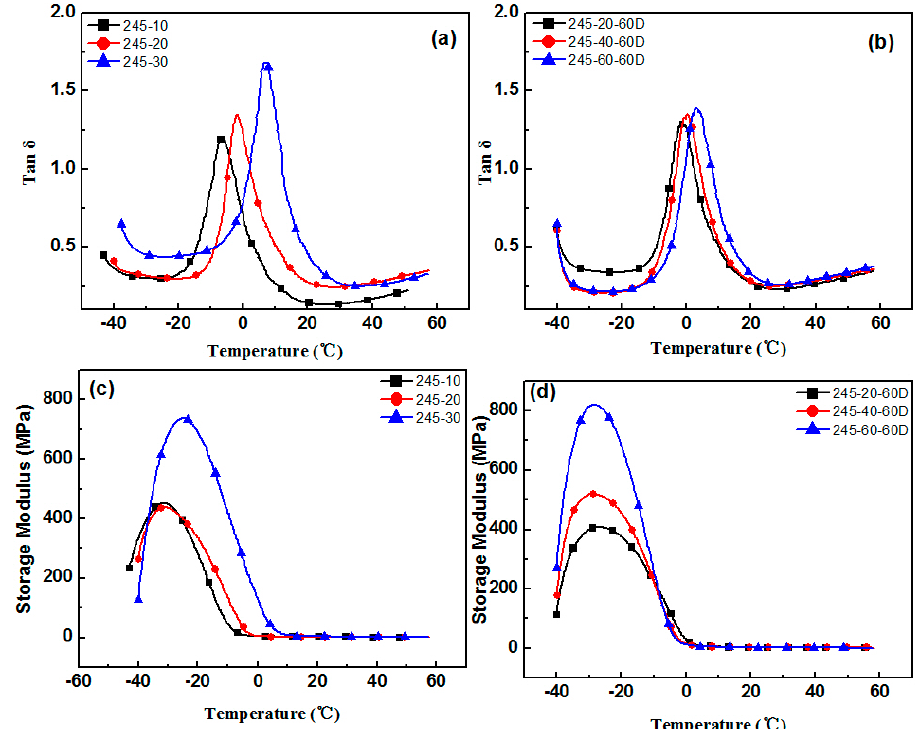
Figure 4. The effect of thermal aging on the storage modulus and tan δ of the XNBR/XH-245 blends: ( a ) tan δ of XNBR/XH-245; ( b ) tan δ of XNBR/XH-245 after aging; ( c ) the storage modulus of XNBR/XH-245; ( d ) the storage modulus of XNBR/XH-245 after aging.